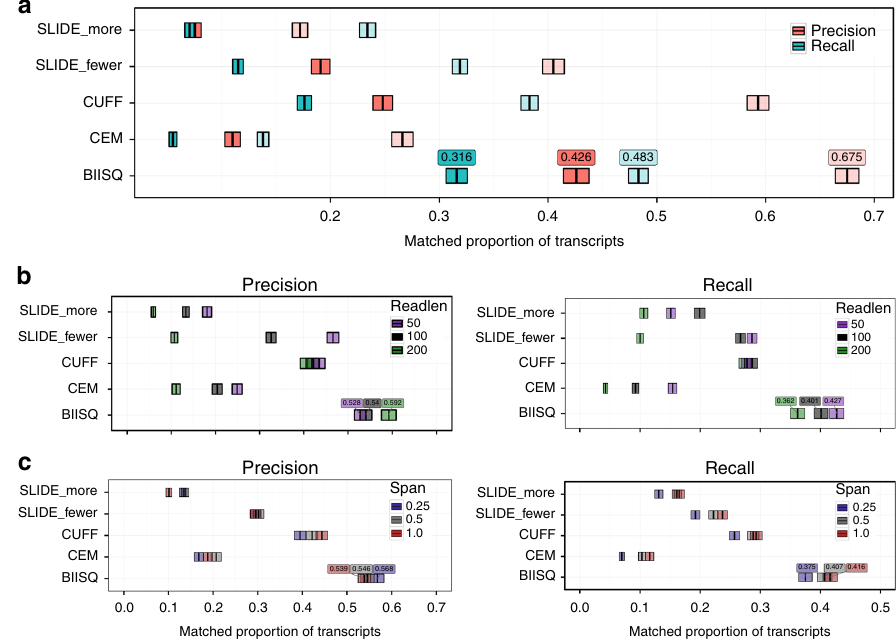
Fig. 4 Comparison of methods on Iso-seq simulations. Precision (red) and recall (blue) of the results from BIISQ , CEM, Cuf fl inks (CUFF), SLIDE_more, and SLIDE_fewer applied to a the short-read data simulated from Iso-Seq reads; b simulated data split by read length; and c simulated data split by span. Transparent fi ll denotes partial precision and recall with a matching threshold of 0.2. The thick center bars denote the mean precision or recall, and the fi ll denotes twice the standard error. The best (partial) precision and recall values are annotated above their respective